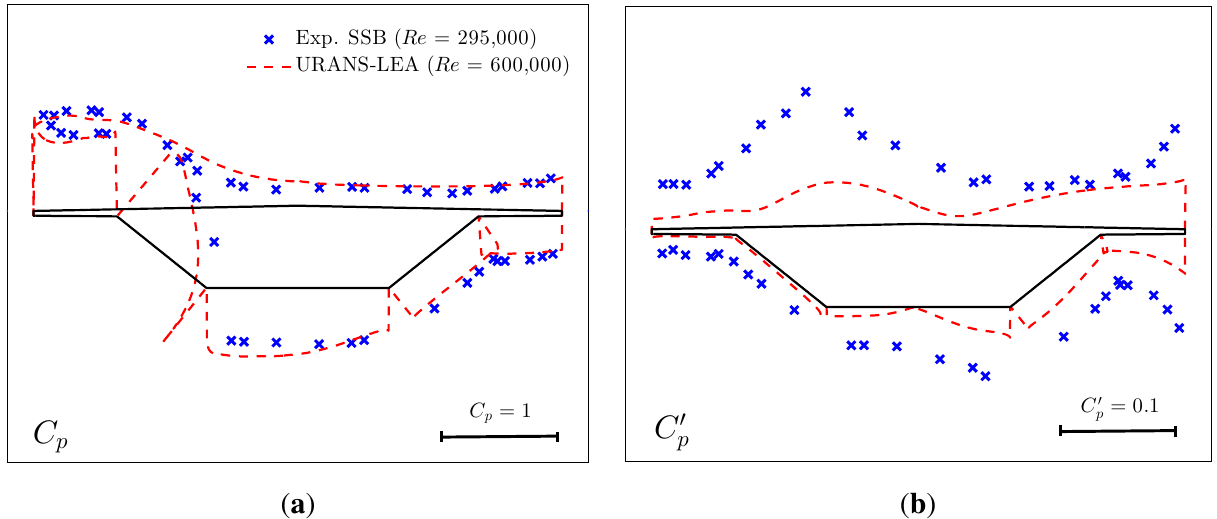
Figure 20. Mean ( a ) and standard deviation ( b ) values of the pressure coefficients for the configuration with perfectly sharp edges. The experimental results for the SSB section model refer to a null angle of attack and to the bare-deck configuration